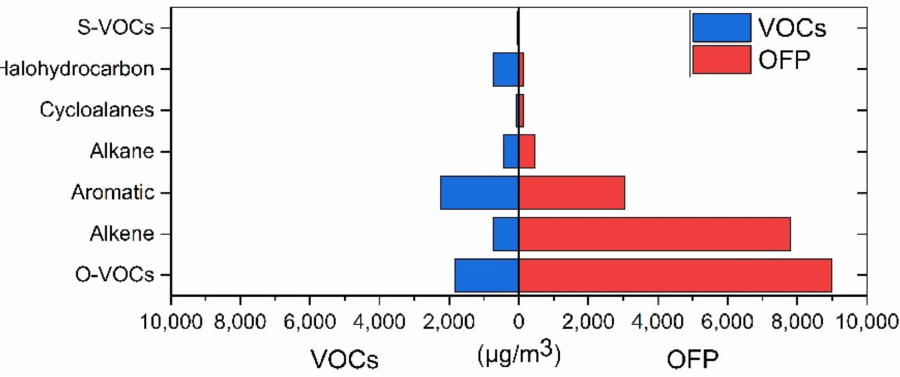
Figure 2. Comparison of VOCs concentration and OFP